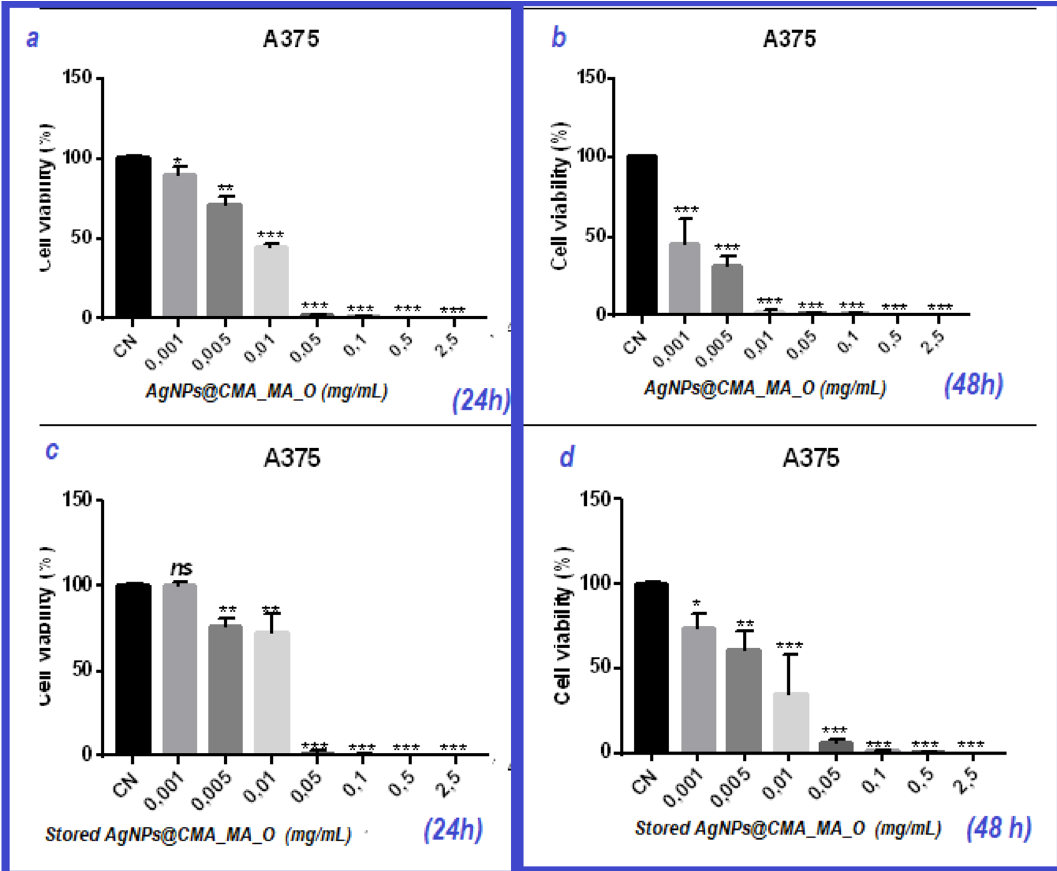
Figure 6. Cytotoxic effect of AgNPs@C_MA_O on melanoma A375 cancer cells. A375 cells were exposed to different concentrations of AgNPs : at 2.5, 0.5, 0.1, 0.05, 0.01, 0.005, 0.001 and 0 mg/ml concentrations for 24 h (a) and 48 h (b) ; obtained results show reaching IC50 at 0.01 mg/mL and 0.005 mg/mL respectively. (c,d) demonstrates that after 6 months AgNPs did not lose their cytotoxic